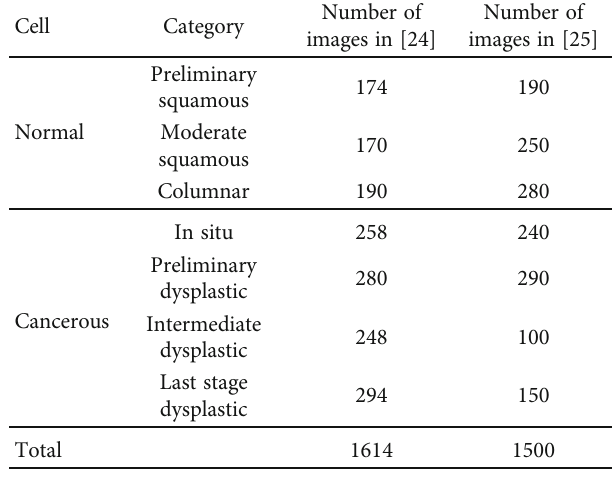
Table 1: Image categories and distribution in datasets [24, 25].